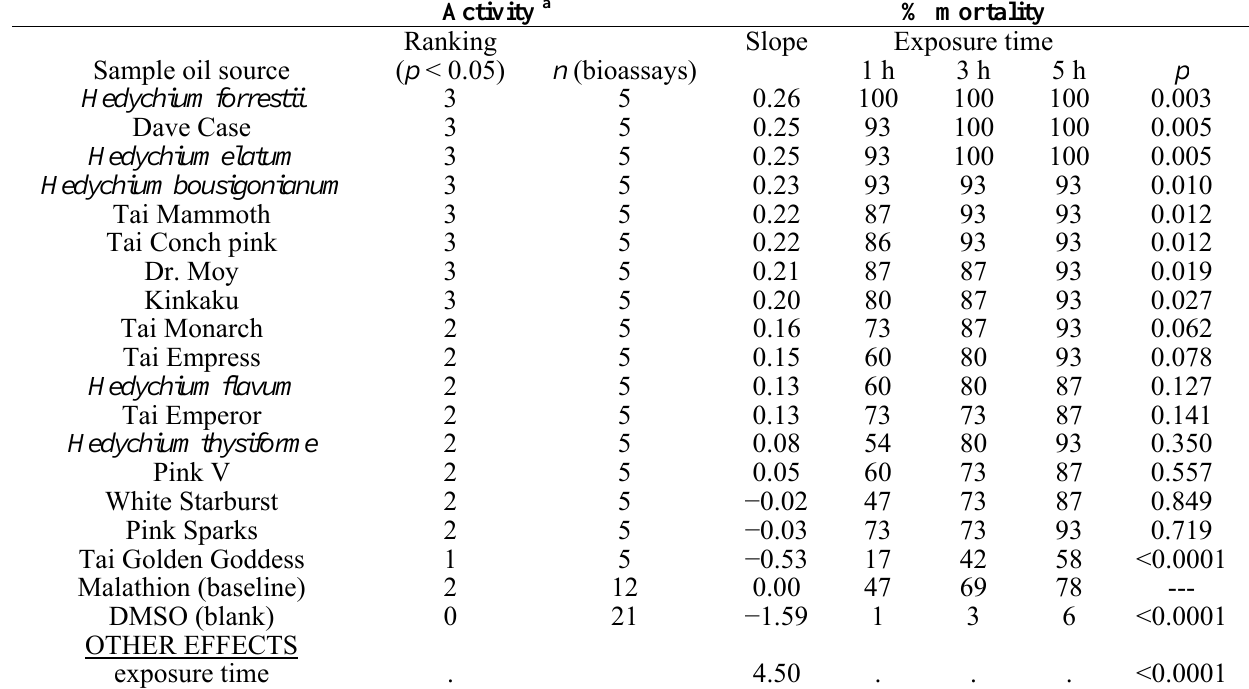
Table 2. Mortality of adult azalea lace bugs, Stephanitis pyrioides (Scott), to 17 Hedychium essential oil extracts and one commercial insecticide (Malathion).All oils from each species or cultivar were compared at a single concentration of 10 mg·L − 1